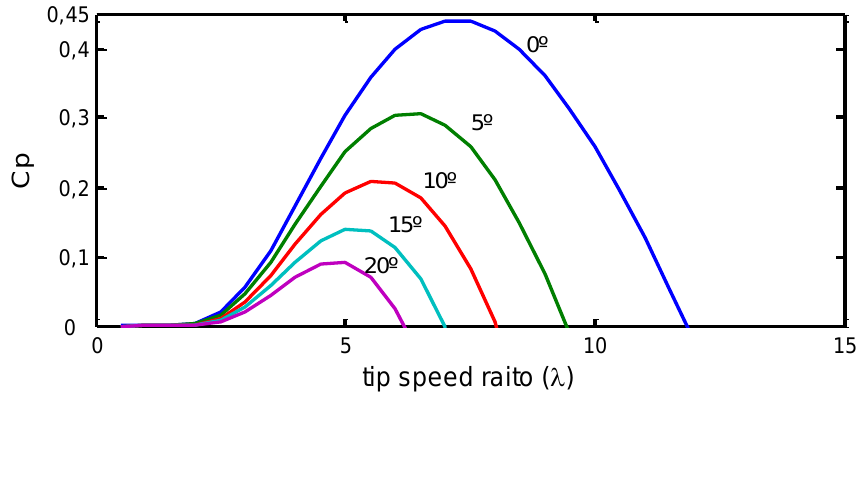
Figure 1. Cp curves suggested by Slootweg for dynamic